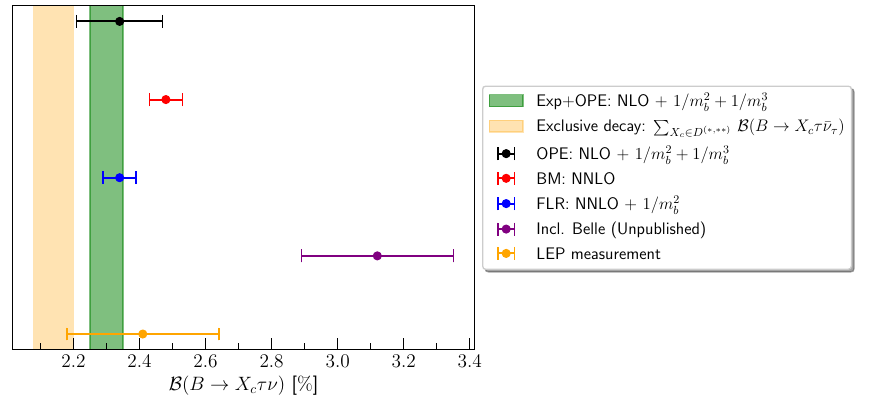
Figure 1 . Comparison of our predictions for the branching ratio B ( B → X c τν ) with previous determinations and with the sum over exclusives from [43]. We also quote the measurements of LEP and the unpublished Belle measurement (see text for